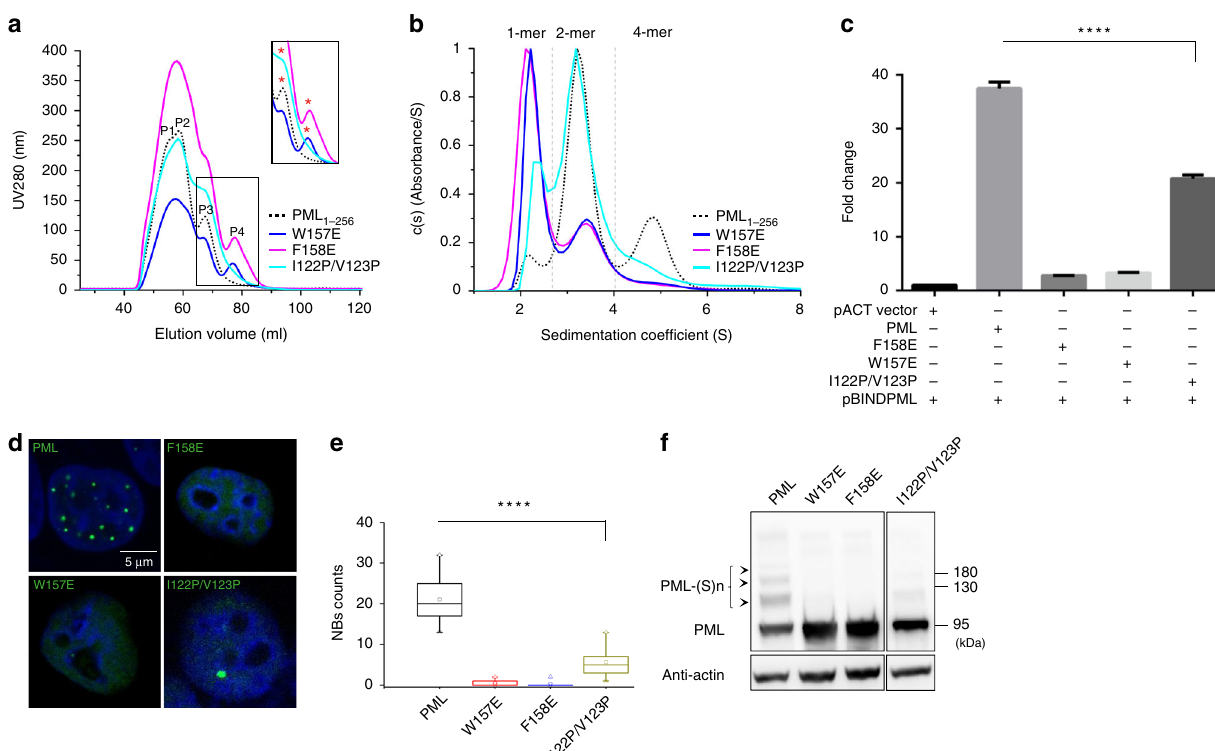
Fig. 5 More in vitro and in vivo analyses of RBCC oligomerization and PML NB biogenesis. a Gel fi ltration characterization of WT and mutant PML 1 – 256 . WT, dashed line. W157E, blue line. F158E, magenta line. I122P/V123P, cyan line. The elution P3/P4 peaks that were subjected to analytical ultracentrifugation analysis in ( b ) are highlighted with “ * ” . Source data are provided as a Source Data fi le. b Analytical ultracentrifugation assay. The WT and mutants are colored using the same scheme as ( a ). The monomeric, dimeric, and tetrameric assemblies are separated with dashed lines. Source data are provided as a Source Data fi le. c Mammalian two-hybrid assay. The relative luciferase activities (RLU) were used to monitor the PML self-interaction. The interactions between WT and different mutants are all normalized against the pACT vector:pBIND-PML interaction ( = 1). Values are means ± S.E. **** p < 0.0001 (derived from student t test) are used to show statistical signi fi cance between WT and mutants. All experiments have been done >3 independent replicates. Source data are provided as a Source Data fi le. d Immuno- fl uorescence of HeLa Pml − / − cells that contained EGFP-PML, EGFP-PML W157E ,